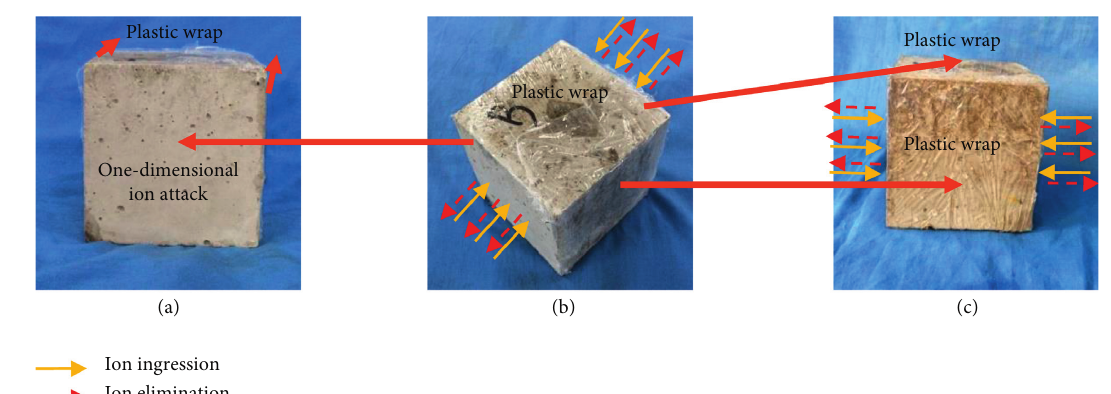
Figure 3: One-dimension ion attack coating system. (a) One-dimension. (b) Vertical view ion attack sides. (c) Coating system of specimen 2.